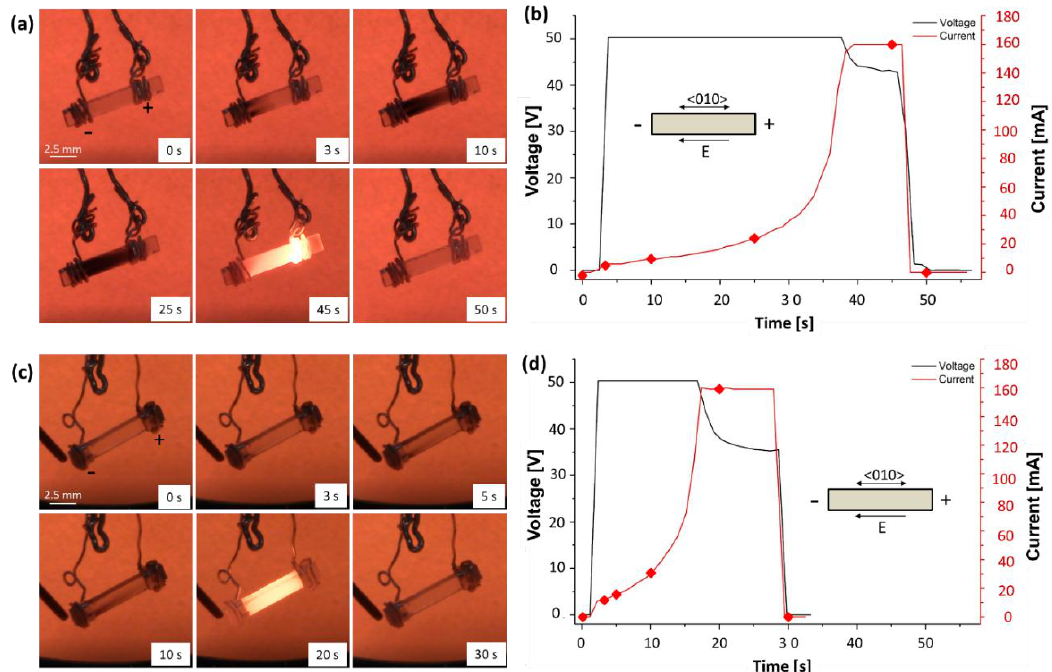
Figure 2. Video stills recorded using a digital camera at different intervals during a DC ( ∆ V lim = 50 V; I lim = 165 mA) FS experiment carried out with ( a , b ) “bad contact”; and ( c , d ) “good contact”. The six red dots give the electrical parameters for the corresponding video stills. The experiments were carried out in air using a (100)-orientation single crystal, with cross section of 2 mm 2